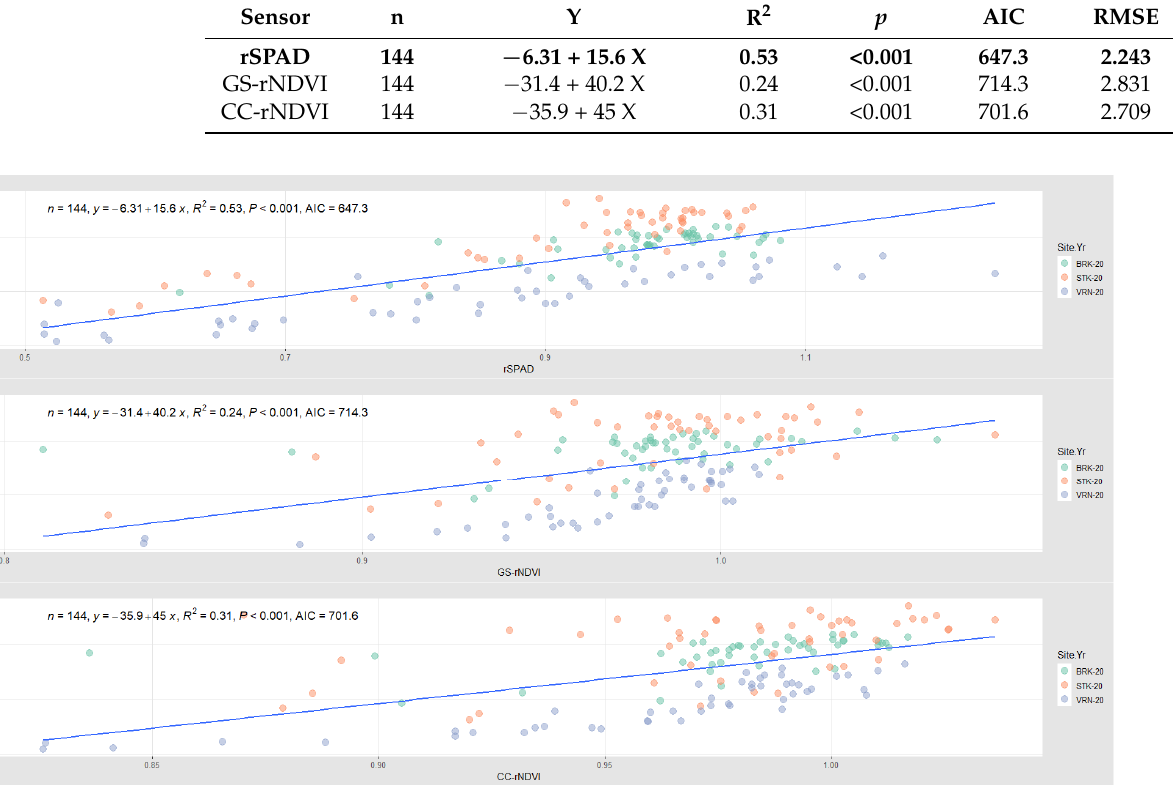
Figure 2. Sensor comparison between the relative VI values for the SPAD ( A ), GreenSeeker ( B ), and Crop Circle sensors ( C ) at the VT stage. The population for each equation is represented by n, the equation is represented by y, the coefficient of determination is represented by R2, the p -value by P, and the Akaike Information Criterion by AIC. Table 6. Sensor comparison between the relative VI values for the SPAD, GreenSeeker, and Crop Circle sensors. Data were collected at the VT stage from the Brooksville, Starkville, and Verona 2020 sites. The best fit sensor based on R 2 , AIC, and RMSE is bolded.